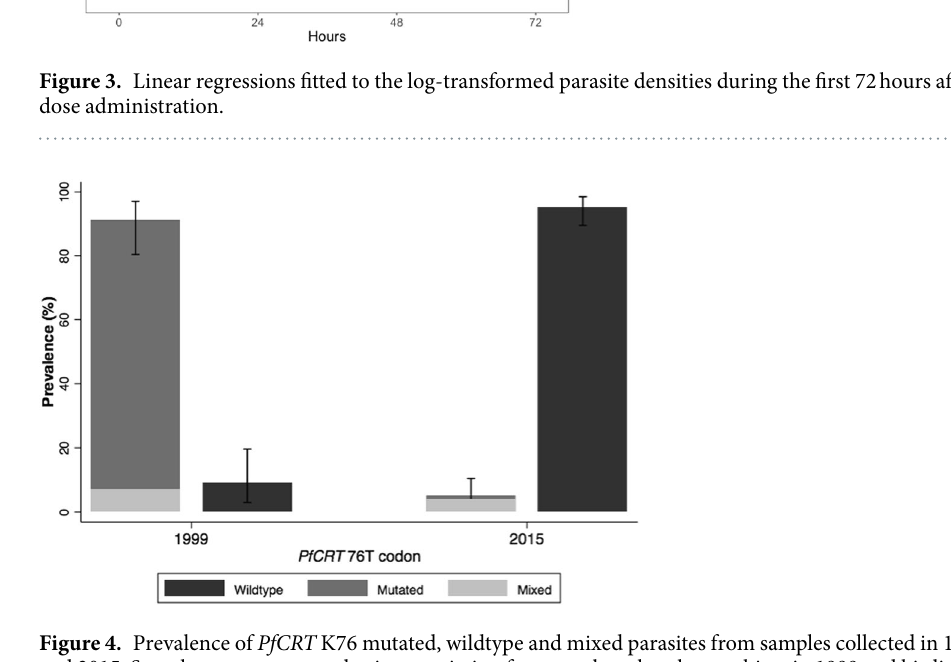
Figure 4. Prevalence of PfCRT K76 mutated, wildtype and mixed parasites from samples collected in 1999 and 2015. Samples were genotyped using restriction fragment length polymorphism in 1999 and bi-directional DNA sequencing in